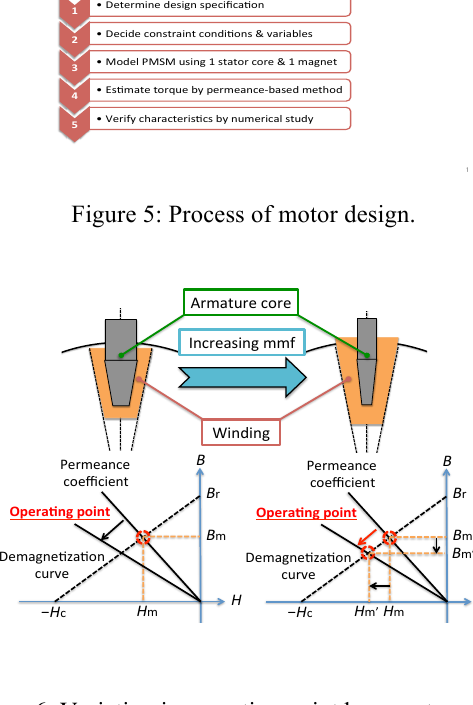
Figure 6: Variation in operating point by armature mmf.